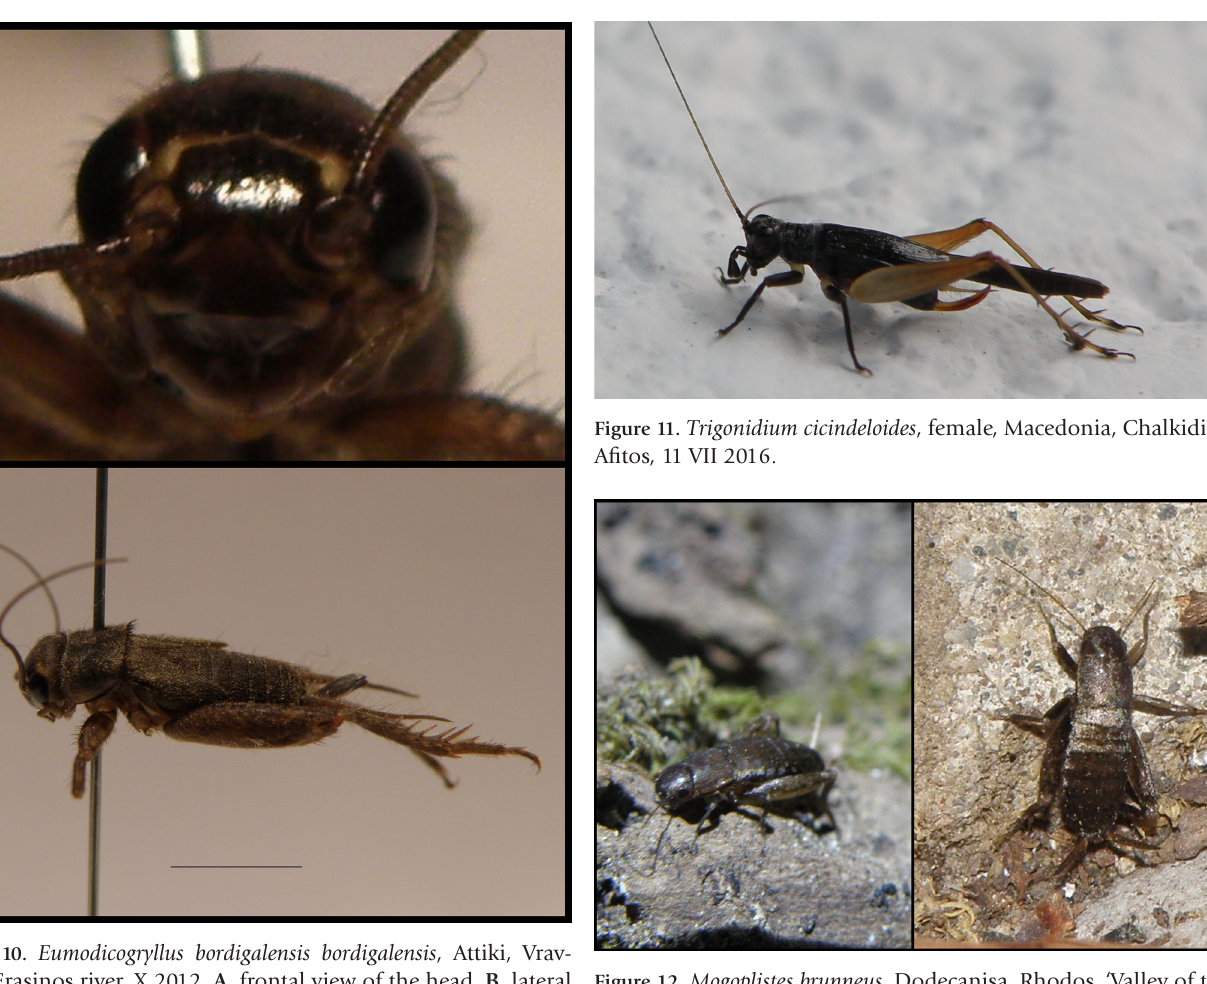
Figure 12. Mogoplistes brunneus , Dodecanisa, Rhodos, ‘Valley of the Butterflies’, 8 X